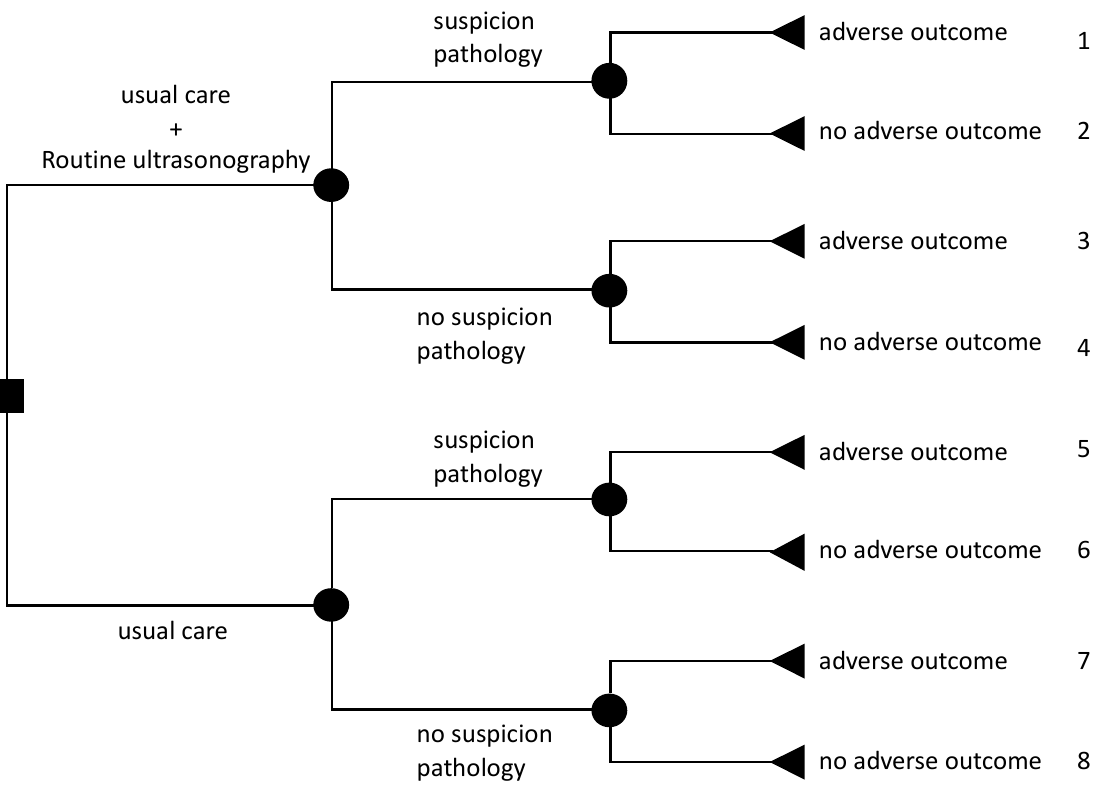
Figure 1. Decision tree showing possible outcome pathways.